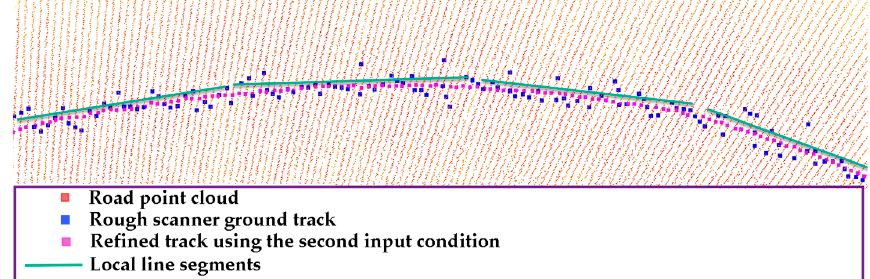
Figure 17. The estimated scanner ground track of the two kinds of input conditions at a bend (in Data